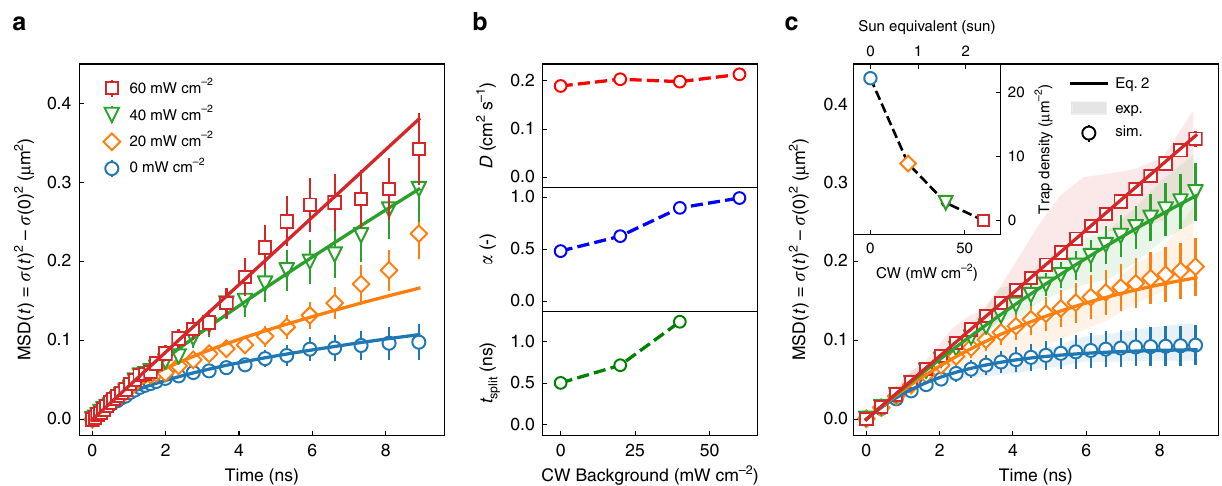
Fig. 2 Exciton diffusion with different background excitation intensities. a Mean-square-displacement of the exciton population for different continuous wave (CW) background intensities. Experimental values are displayed with open markers, while the fi t functions (Supplementary Eq. 9), de fi ned through the parameters D , α , and t split , are displayed as solid lines. Reported errors represent the uncertainty in the fi tting procedure for σ ( t ) 2 . b Diffusivity D , diffusion exponent α , and the onset of subdiffusive regime t split extracted from fi ts in a . c Theoretical model (Eq. 2, solid lines), and numerical simulation (open markers) for exciton diffusion with different trap densities. Experimental values from a are displayed as shaded areas for comparison. Reported errors represent the standard deviation of 10 4 Brownian motion simulations. The inset shows the trap densities found with the simulations. Mirror axis of the inset is the sun equivalent of the background illumination intensity (AM1.5 Global with E photon > E bandgap